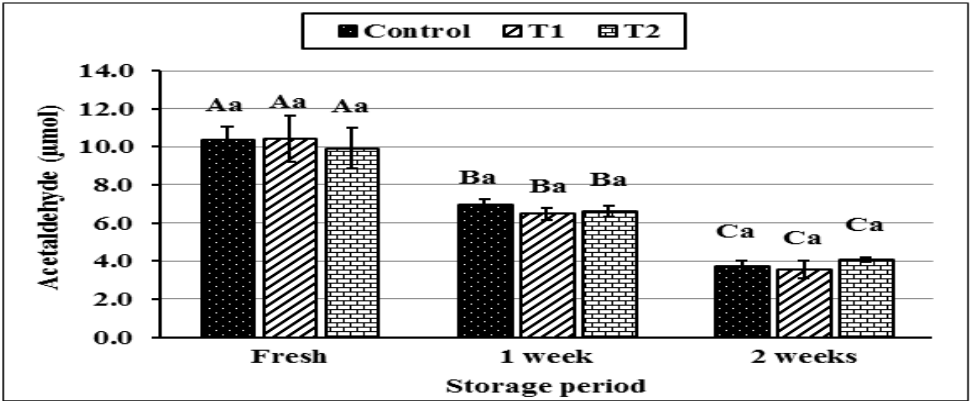
Figure 6. Acetaldehyde of yoghurt during storage period as affected by adding different concen- trations of chromium (CrPic). Control: without Cr (CrPi), T1: with 0.25 ppm Cr (CrPi), T2: fortified with 0.5 ppm Cr (CrPi). Data are mean ± SE for three replicates. Means with different small letters are signifi- cantly different between the treatments ( p ≤ 0.05). Means with different capital letters significantly differ between the storage periods ( p ≤ 0.05).